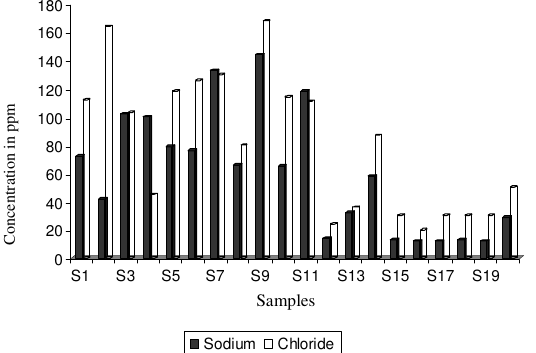
Figure 5. Concentration of sodium and chloride ion (ppm) of water samples collected from Kandarvakottai (S1 to S10) and Karambakudi (S11 to S20) areas. Due to the absence of chemical industries in the near by places of this study area, no cyanide was identified even in trace amounts. The fluoride ion concentrations of these samples were very low and all these facts showed a good sign for the usage of this water for drinking and cooking